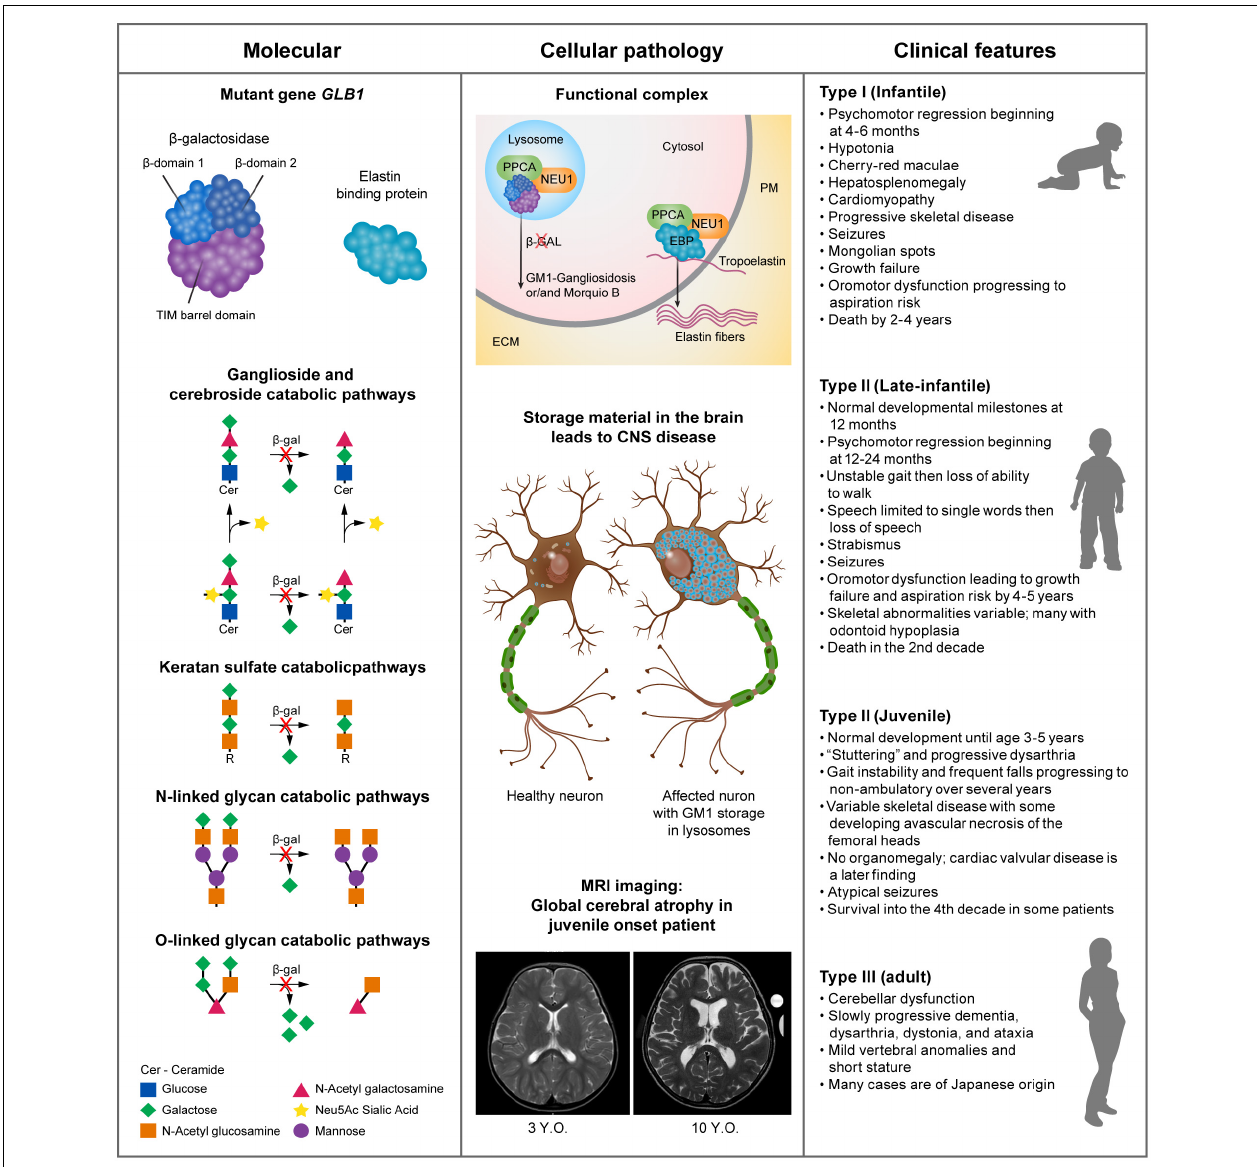
FIGURE 1 | Pathogenesis and clinical manifestations. Panel 1: human β -GAL is composed of a catalytic TIM barrel domain followed by β -domain 1 and β -domain 2 (Ohto et al., 2012). Mutations in the GLB1 gene lead to impaired enzyme activity, which results in the progressive accumulation of complex gangliosides, specifically GM1. This, in turn, initiates a series of pathogenic events that ultimately lead to neurodegeneration (Kolter, 2012; Annunziata et al., 2018). Panel 2: through alternative splicing, the GLB1 gene gives rise to two transcripts, one encoding the hydrolytic enzyme β -galactosidase and the other the elastin binding protein (EBP). The primary role of EBP is to chaperone the deposition of elastin fibers in the extracellular matrix (ECM). β -galactosidase (GLB1) and EBP are found in complex with PPCA and NEU1 in lysosomes and the plasma membrane (PM), respectively (Caciotti et al., 2005; Bonten et al., 2014). Panel 3: although GM1 gangliosidosis is a disease continuum it can be loosely divided into 3 types, with Type II having 2 subtypes. The common use of a synthetic fluorogenic substrate to measure β -GAL activity makes it difficult to establish an accurate correlation between residual enzyme activity and clinical outcome. This may also be complicated by the regulatory and post posttranslational mechanisms that influence GM1-ganglioside catabolism and may vary among patients (Breiden and Sandhoff, 2019). The main symptoms of the disease commonly found in each type/subtype are